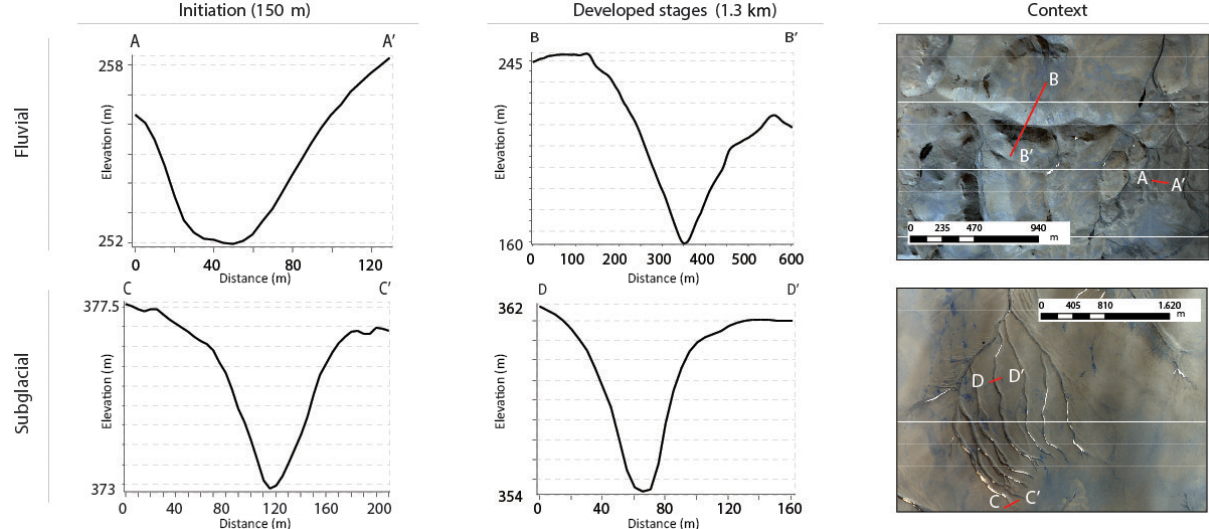
Figure 6. Cross-sectional evolution of a fluvial (upper row) and subglacial (bottom row) channel, with satellite imagery for context on the right column. In the subglacial case, the initial width and the shape remain largely unchanged over length, whereas the river cross section grows monotonically both in width and depth with distance. Note the differences in depth and length in the section scale bars.